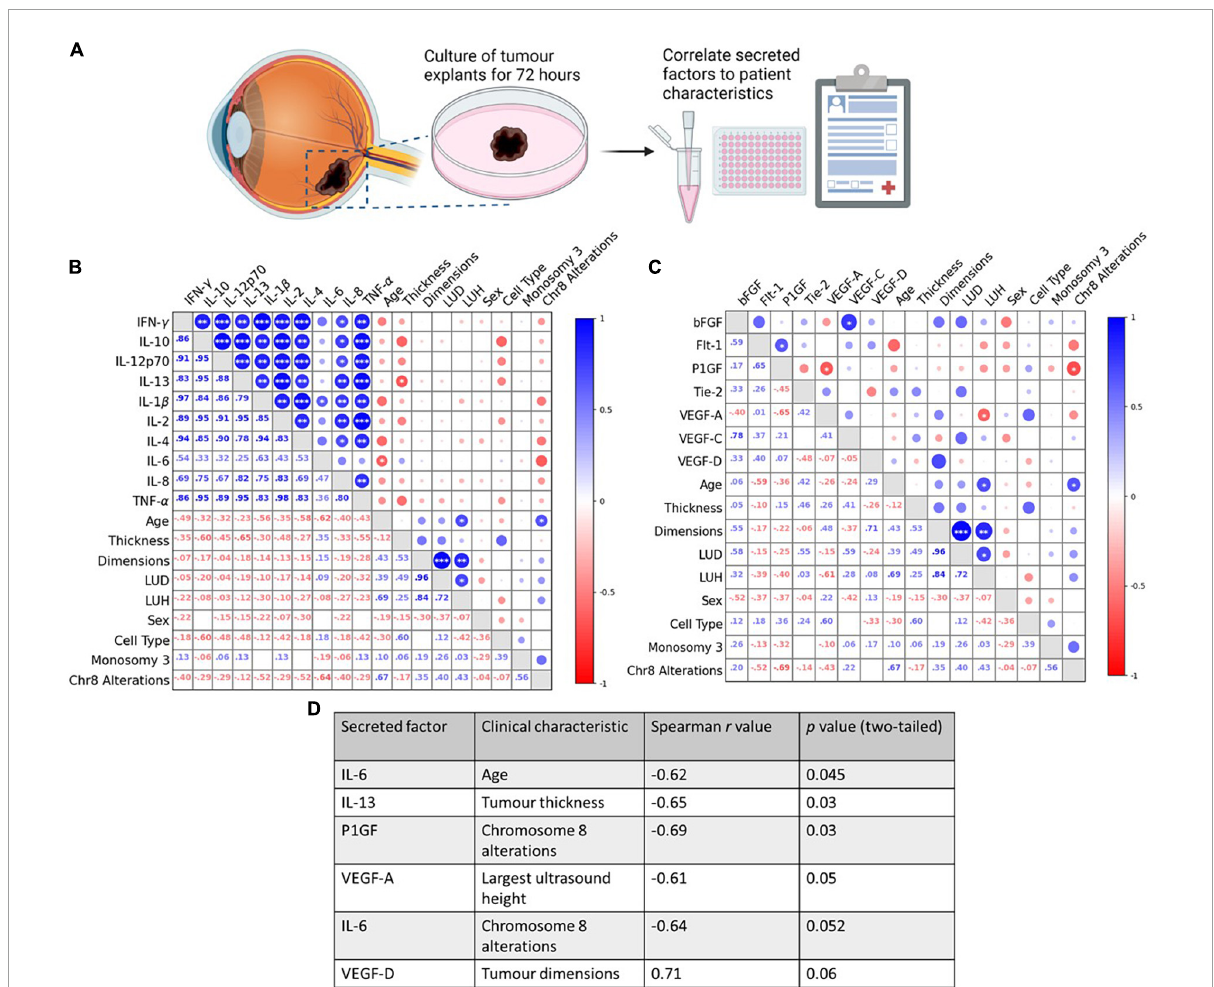
FIGURE2 Tumour secretion of IL-6, IL-13, VEGF-A, and PlGF correlate with clinical characteristics in ex vivo, control-treated, primary UM patient tumours. (A) Schematic of the explant culture protocol with vehicle control. Following 72 h of culture, the secretion levels of 10 inflammatory and 7 angiogenic analytes were compared in n = 11 freshly isolated UM tumours treated with vehicle control, to determine if correlations existed between secretions in TCM and patients’ clinical parameters. (B,D) A significant negative correlation exists between IL-6 secretion and patient age, and IL-13 secretion and tumour thickness. (C,D) A significant negative correlation exists between VEGF-A secretion and largest ultrasound height, and PlGF secretion and chromosome 8 alterations. (D) Table shows all inflammatory and angiogenic secretions with a strong positive (Spearman correlation value > 0.6), or strong negative (Spearman correlation value < –0.6) correlation to a patient clinical characteristic ( n = 11). Although not statistically significant ( p > 0.05), IL-6 secretion shows a strong negative correlation with chromosome 8 alterations, and VEGF-D secretions shows a strong positive correlation with tumour dimensions. Spearman correlation value > 0.6 is considered a strong positive correlation. Spearman correlation value < –0.6 is considered a strong negative correlation. The lower left triangle denotes Spearman correlation values for each comparison. Correlation analysis was conducted using GraphPad Prism 7 software. Correlations are visualized using a correlation plot generated by BioKit for Python. Conditioned media were collected and analyzed by ELISA ( n = 11). Tumour tissue was snap-frozen for protein isolation. Secretion levels of inflammatory and angiogenic mediators were normalized to total protein content prior to statistical analysis. * p < 0.05; ** p < 0.01; *** p < 0.001. LUD, largest ultrasound diameter; LUH, largest ultrasound height. Panel (A) created with